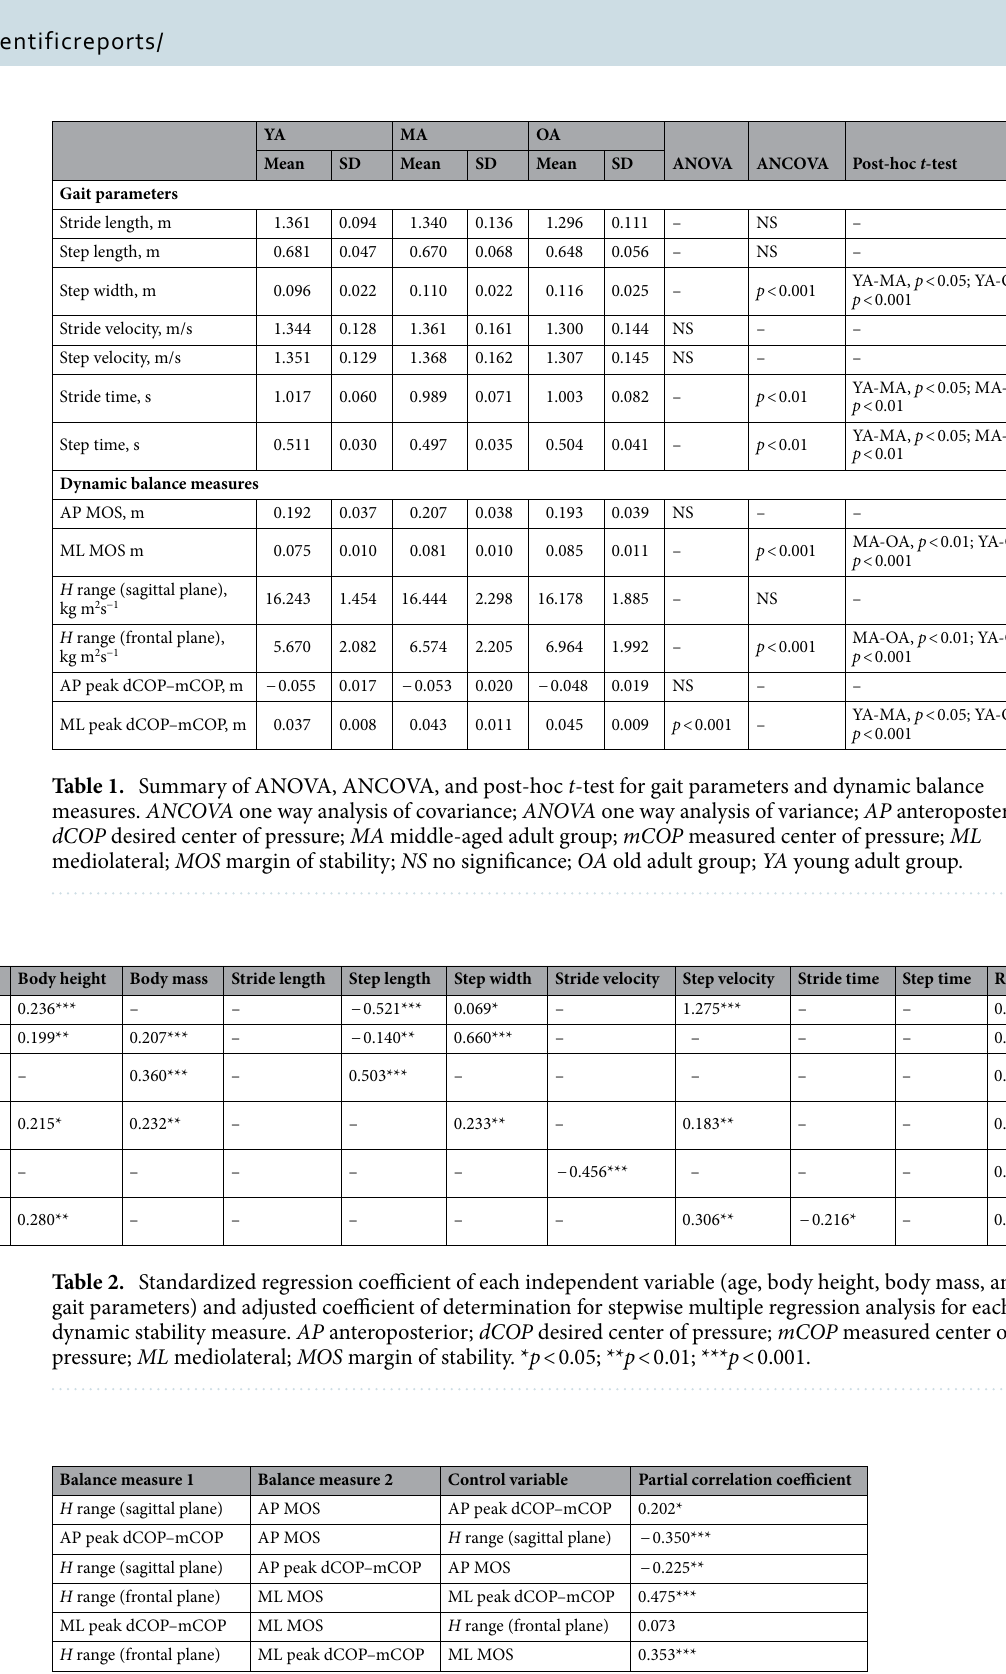
Table 3. Summary of partial correlation analysis among dynamic balance measures in the AP and ML directions. AP anteroposterior; dCOP desired center of pressure; mCOP measured center of pressure; ML mediolateral; MOS margin of stability. * p < 0.05; ** p < 0.01; *** p <